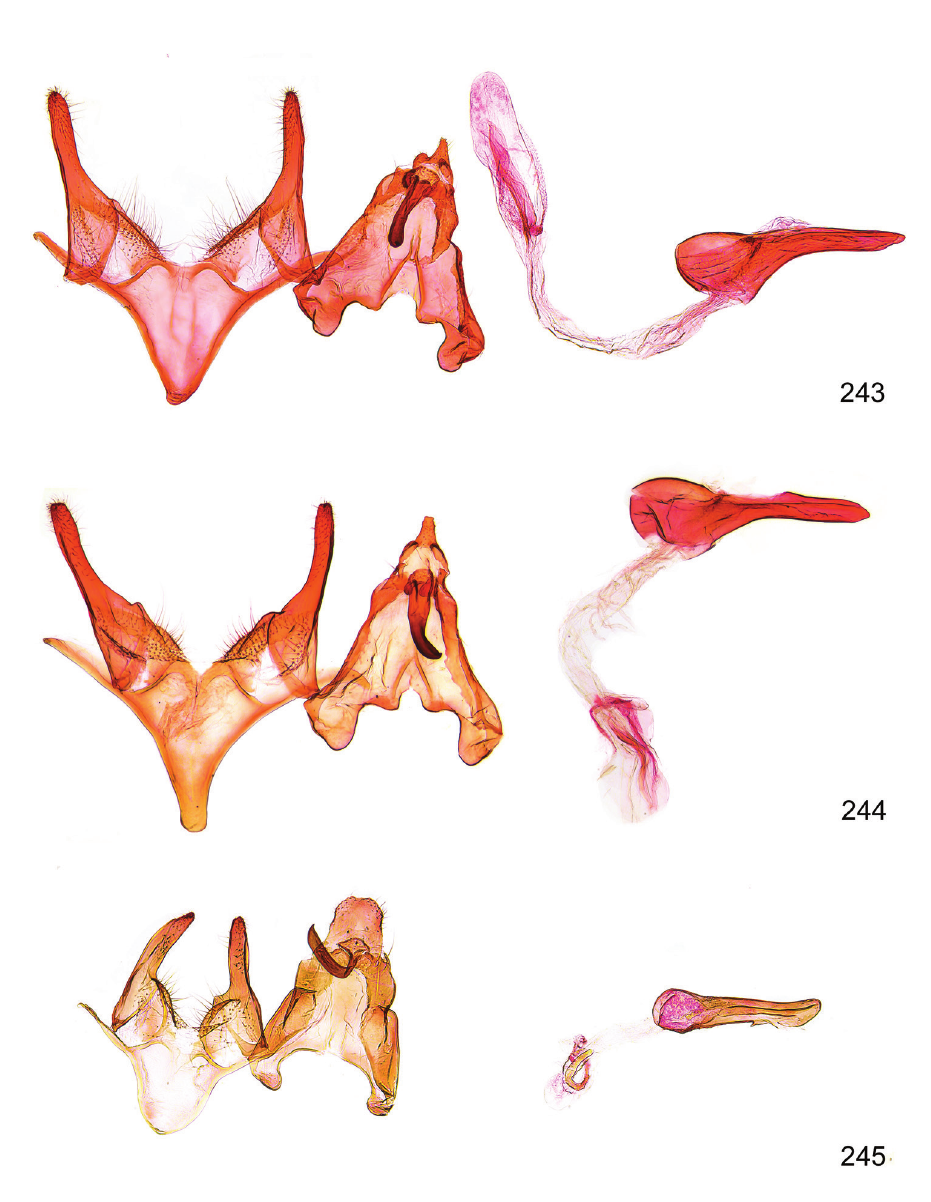
Figures 243–245. Megacraspedus male genitalia. 243 M. argyroneurellus Staudinger, 1871 – Ukraine, GU 16/1427 P.H. (RCAB) 244 M. argyroneurellus Staudinger, 1871 – Iran, gen. slide 16.658 (NHMW) 245 M. ibericus sp. n. – Paratype, Spain, GU 16/1431 P.H.